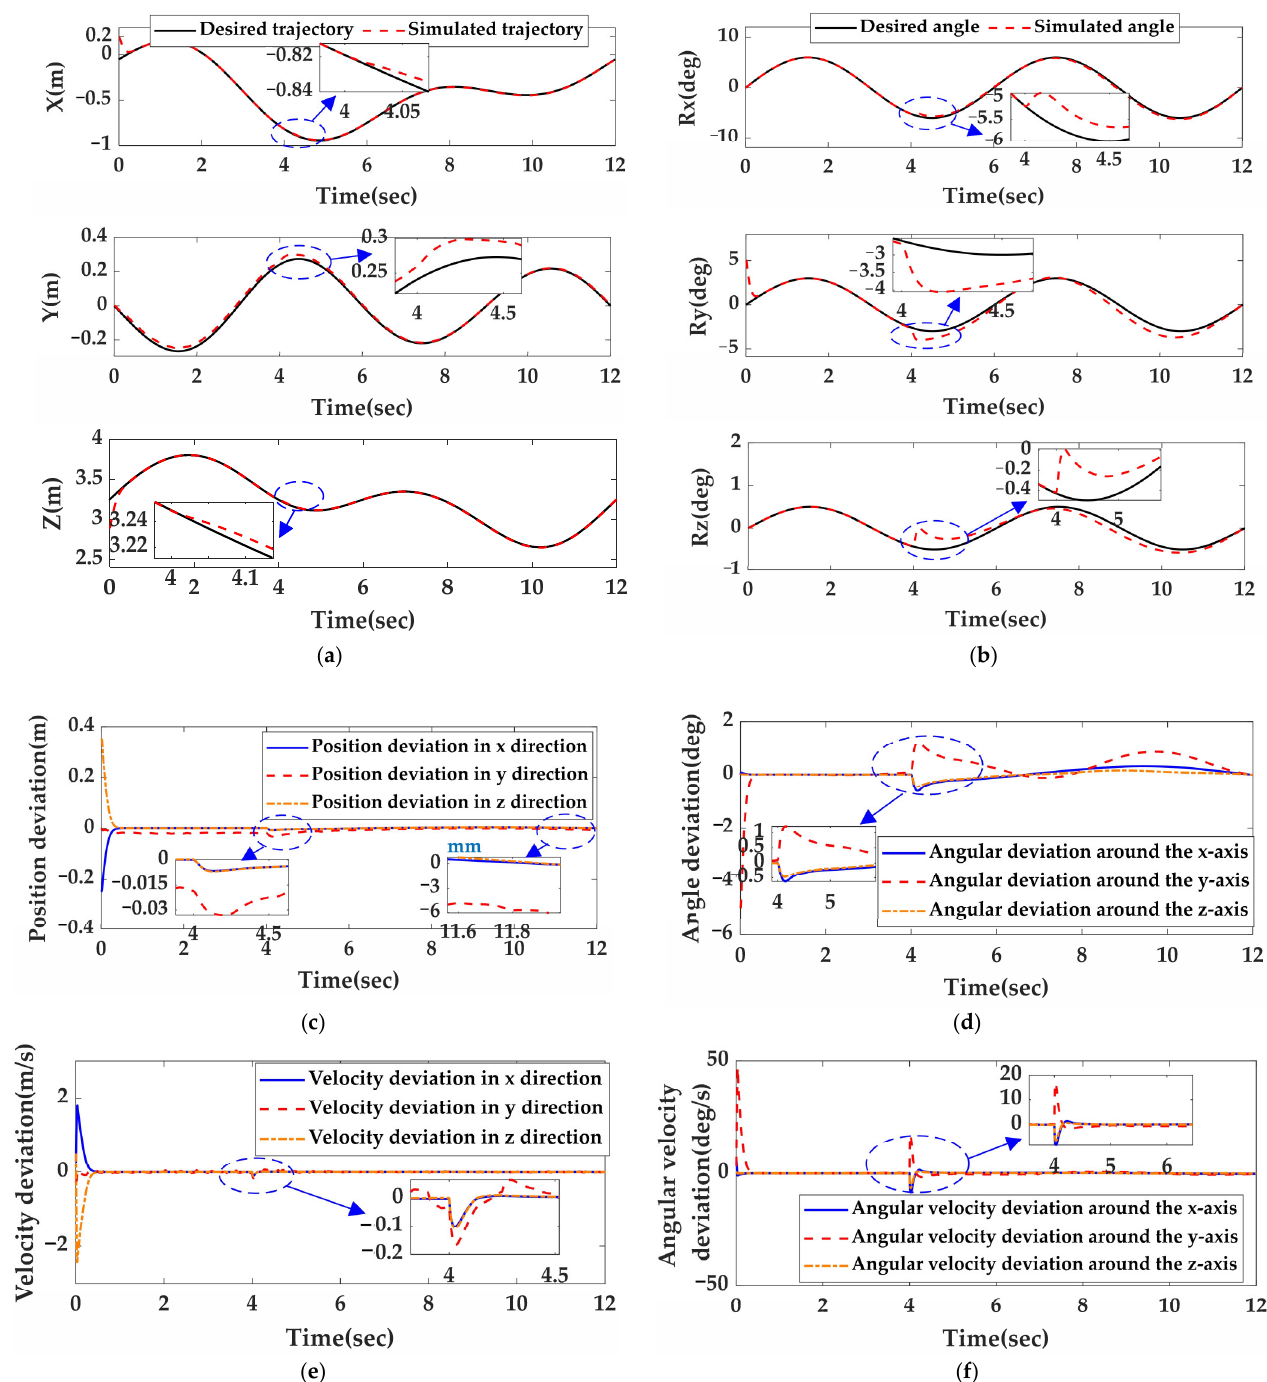
Figure 10. The simulation results with wave excitation: ( a ) position tracking; ( b ) angle tracking; ( c ) position deviation; ( d ) angular deviation; ( e ) velocity deviation; ( f ) angular velocity deviation.